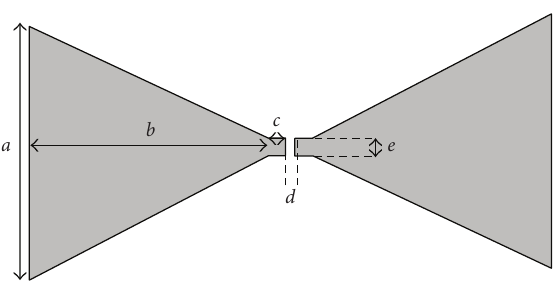
Figure 3: Fabricated prototype RFID bow-tie antennas.